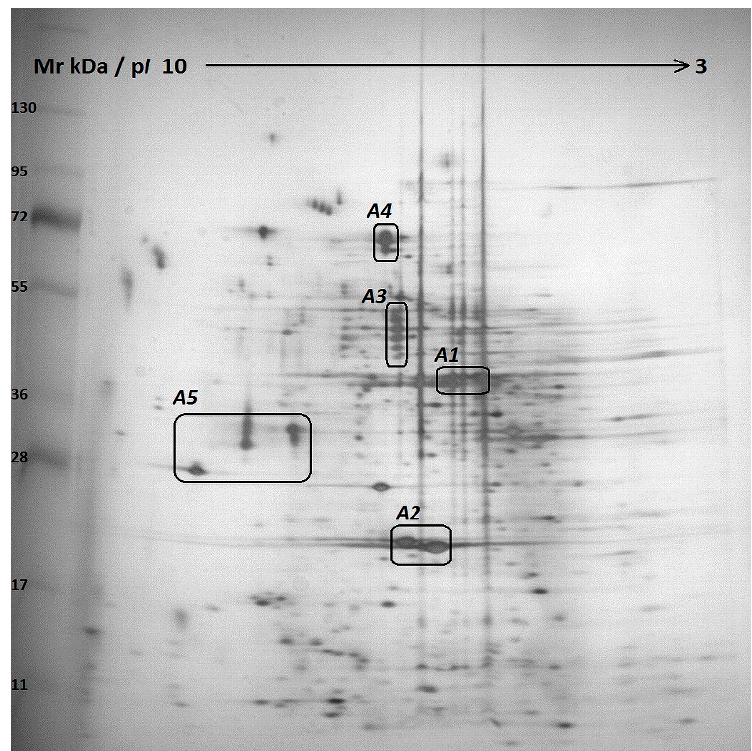
Figure 1. Two dimensional gel electrophoregram of crude Agaricus bisporus extract (ABE). The proteins were precipitated from ABE and resolved by 2D electrophoresis. The protein composition of each area (A1–A5) is given in Table 1.